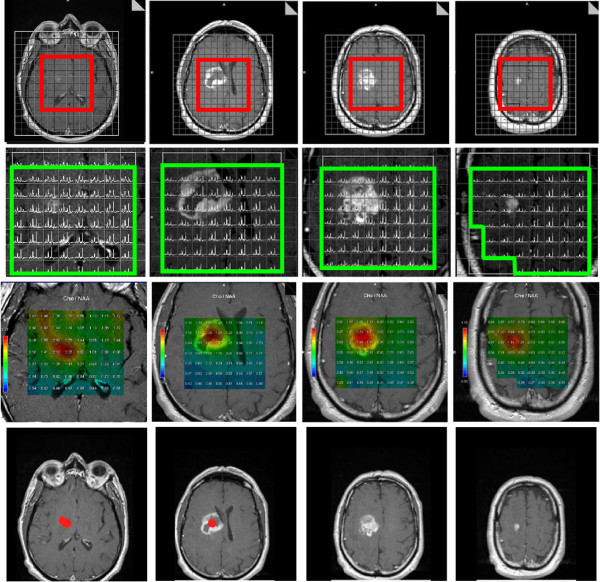
3D-MRSI acquisition before radiation therapy treatment of a 53 year-old unresected patient with confirmed glioblastoma located in the right capsulo-thalamic region (first row, the volume of acquisition is framed in red). On the T1-Gd anatomic MR images showing contrast-enhancing disease, the MRSI volume of interest is defined on a voxel by voxel basis,when alteration of metabolites spectra is observed, the voxel is rejected (green frame on second row). The anatomic-metabolic maps are computed from the above defined volume of interest (third row), the maximum Cho/NAA ratio values are encoded in red color and are respectively from left to right 2.27, 2.30, 1.52 and 1.15. The first two metabolite maps which present ratios of Cho/NAA ≥ 2.00 suggest metabolic tumor activity. Regions of interest corresponding to ratio of Cho/NAA ≥ 2.00 are obtained after normalization and threshold based segmentation from the anatomic-metabolic images, these ROIs are highlighted in red (last row). Note on the first image (last row) that the location of the abnormal spectroscopic region is different and below the contrast-enhancing area.